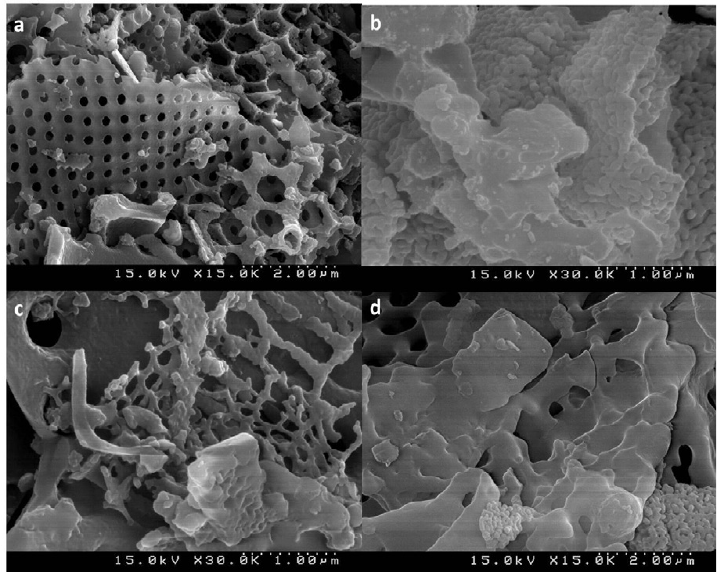
O (b) and 6% Dy-doped Y O -coated diatomite at different magnification 2 3 2 3 (c,d)